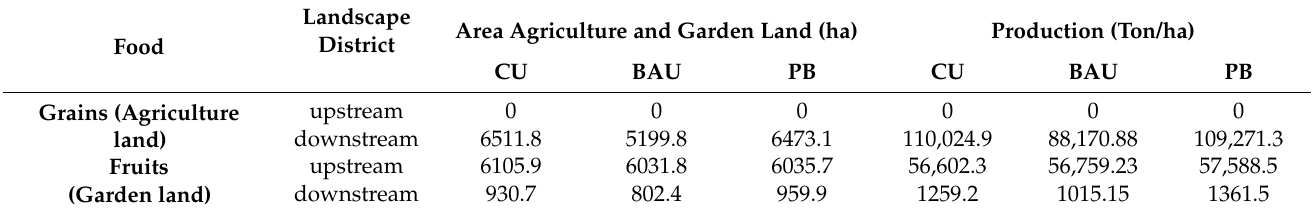
Table 6. Changes in food production under different